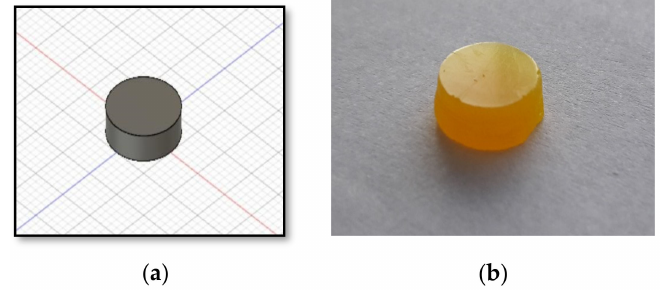
Figure 2. ( a ) 3D model of DLP printlet; ( b ) DLP